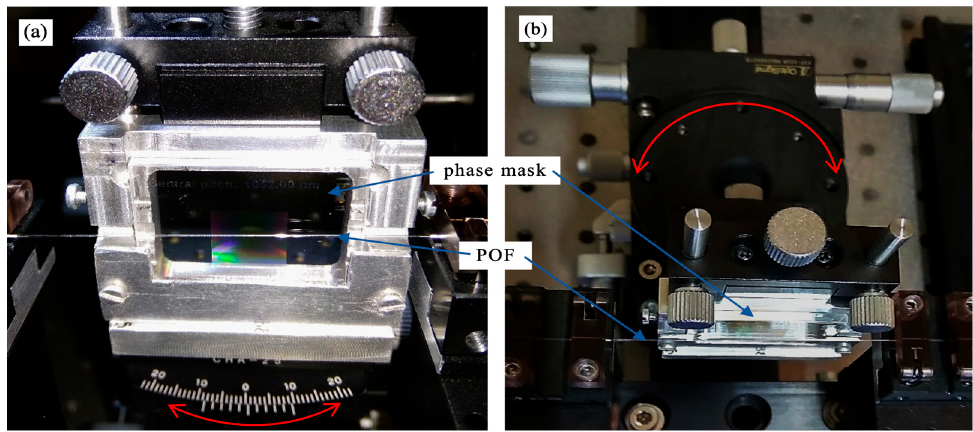
Figure 4. OptoSigma goniometer stage ( a ) and rotational stage ( b ) for precise adjustment of θ and ϕ angles, respectively. The directions of rotation of the phase mask relative to the POF (polymer optical fiber) are marked with red arrows.